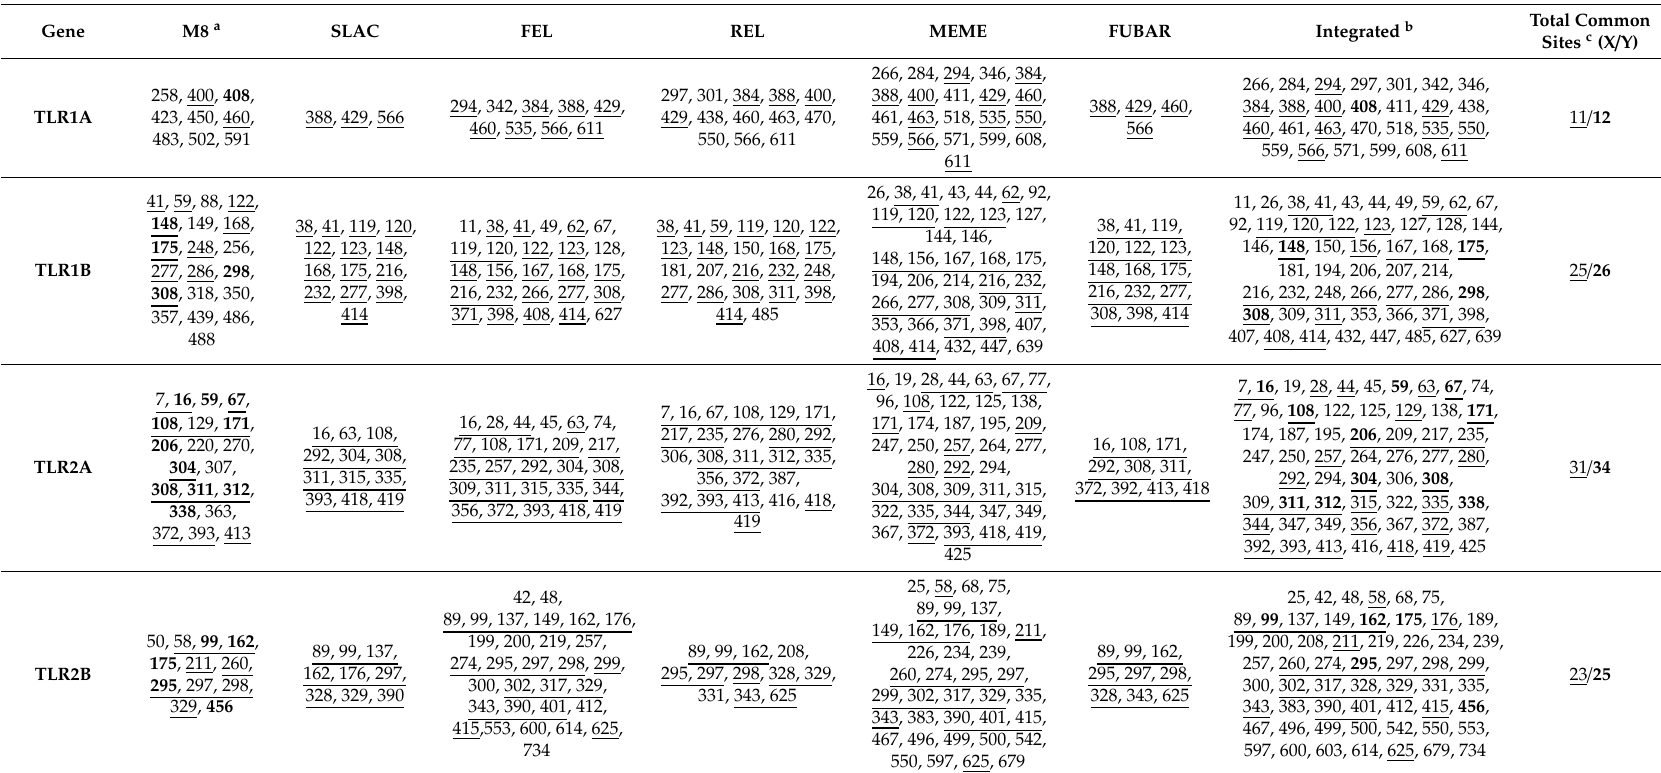
Table 3. Positive selected sites identified by various methods (PAML-M8, SLAC, FEL, REL, MEME, FUBAR, and Integrated). Gene M8 a SLAC FEL REL MEME FUBAR Integrated b